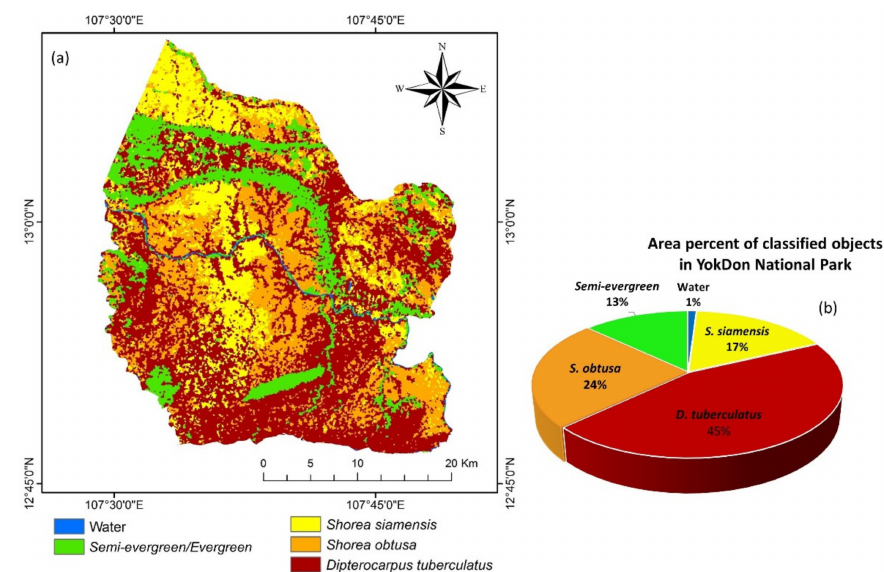
Figure 9. ( a ) Map of BDFs and ( b ) pie chart of area percentage for the classified objects in Yok Don National Park.